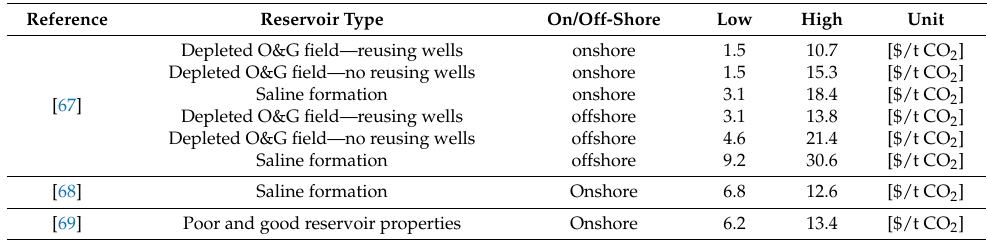
Table 8. Range of storage cost for several reservoir types, either onshore or offshore. All prices are reported in US dollars in 2013.